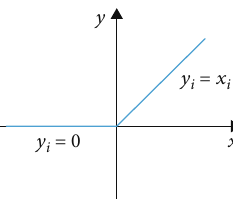
Figure 7: Relus function f ð x Þ = max ð 0, x Þ